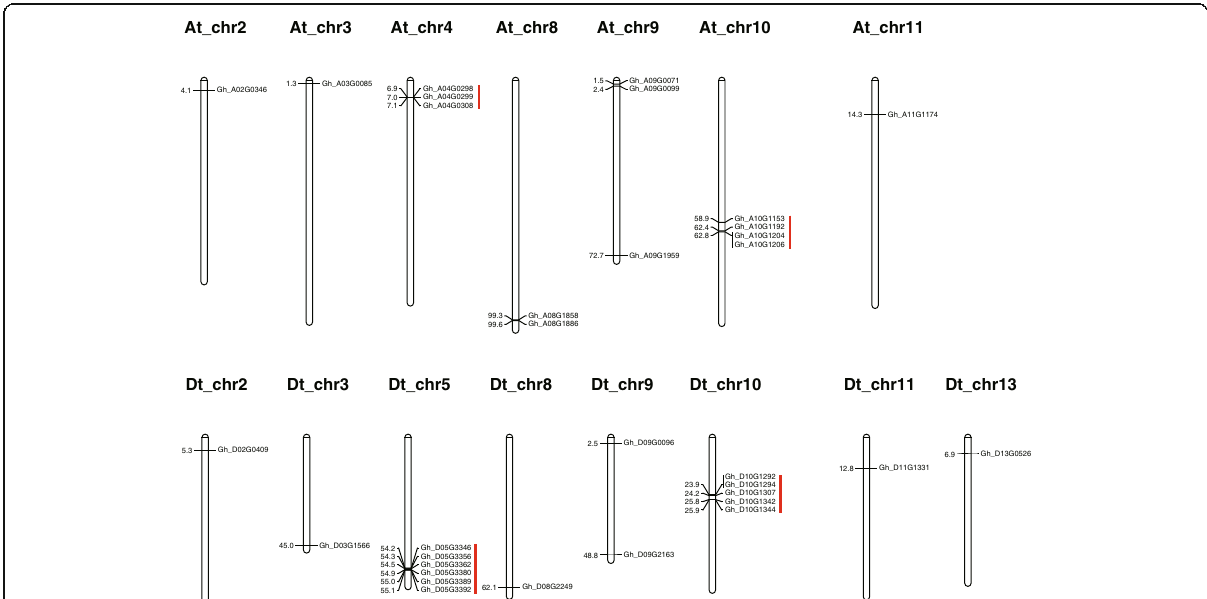
Fig. 1 The putative chromosome location of RFL genes on G. hirsutum . The scale represents megabases (Mb). The red column represents the RFL-rich region